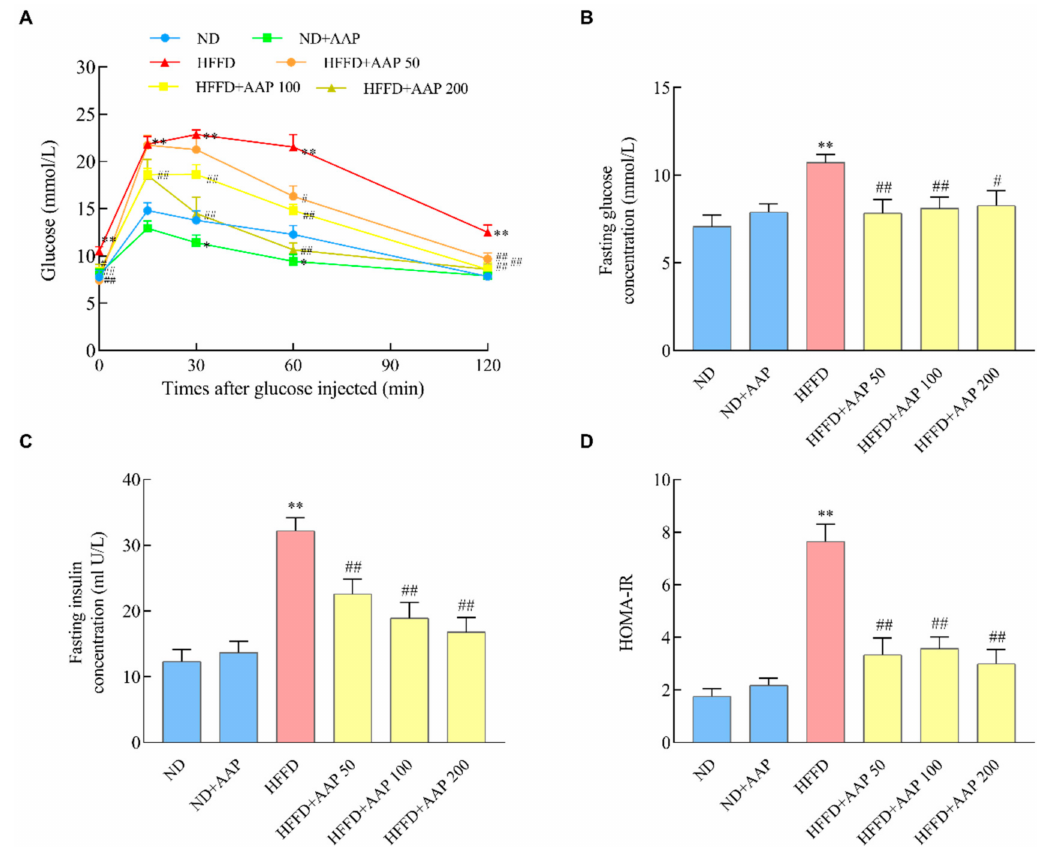
Figure 3. Effects of Auricularia auricula-judae polysaccharides on glucose tolerance and insulin resistance in obese mice that was induced by HFFD. At the end of 12-week feeding, mice were detected by ( A ) glucose tolerance tests; ( B ) fasting glucose levels; ( C ) fasting insulin levels; ( D ) insulin resistance index, HOMA-IR. The data are presented as the mean ± SEM, n ≥ 6, * p < 0.05, ** p < 0.01, vs. ND group, # p < 0.05, ## p < 0.01 vs. HFFD